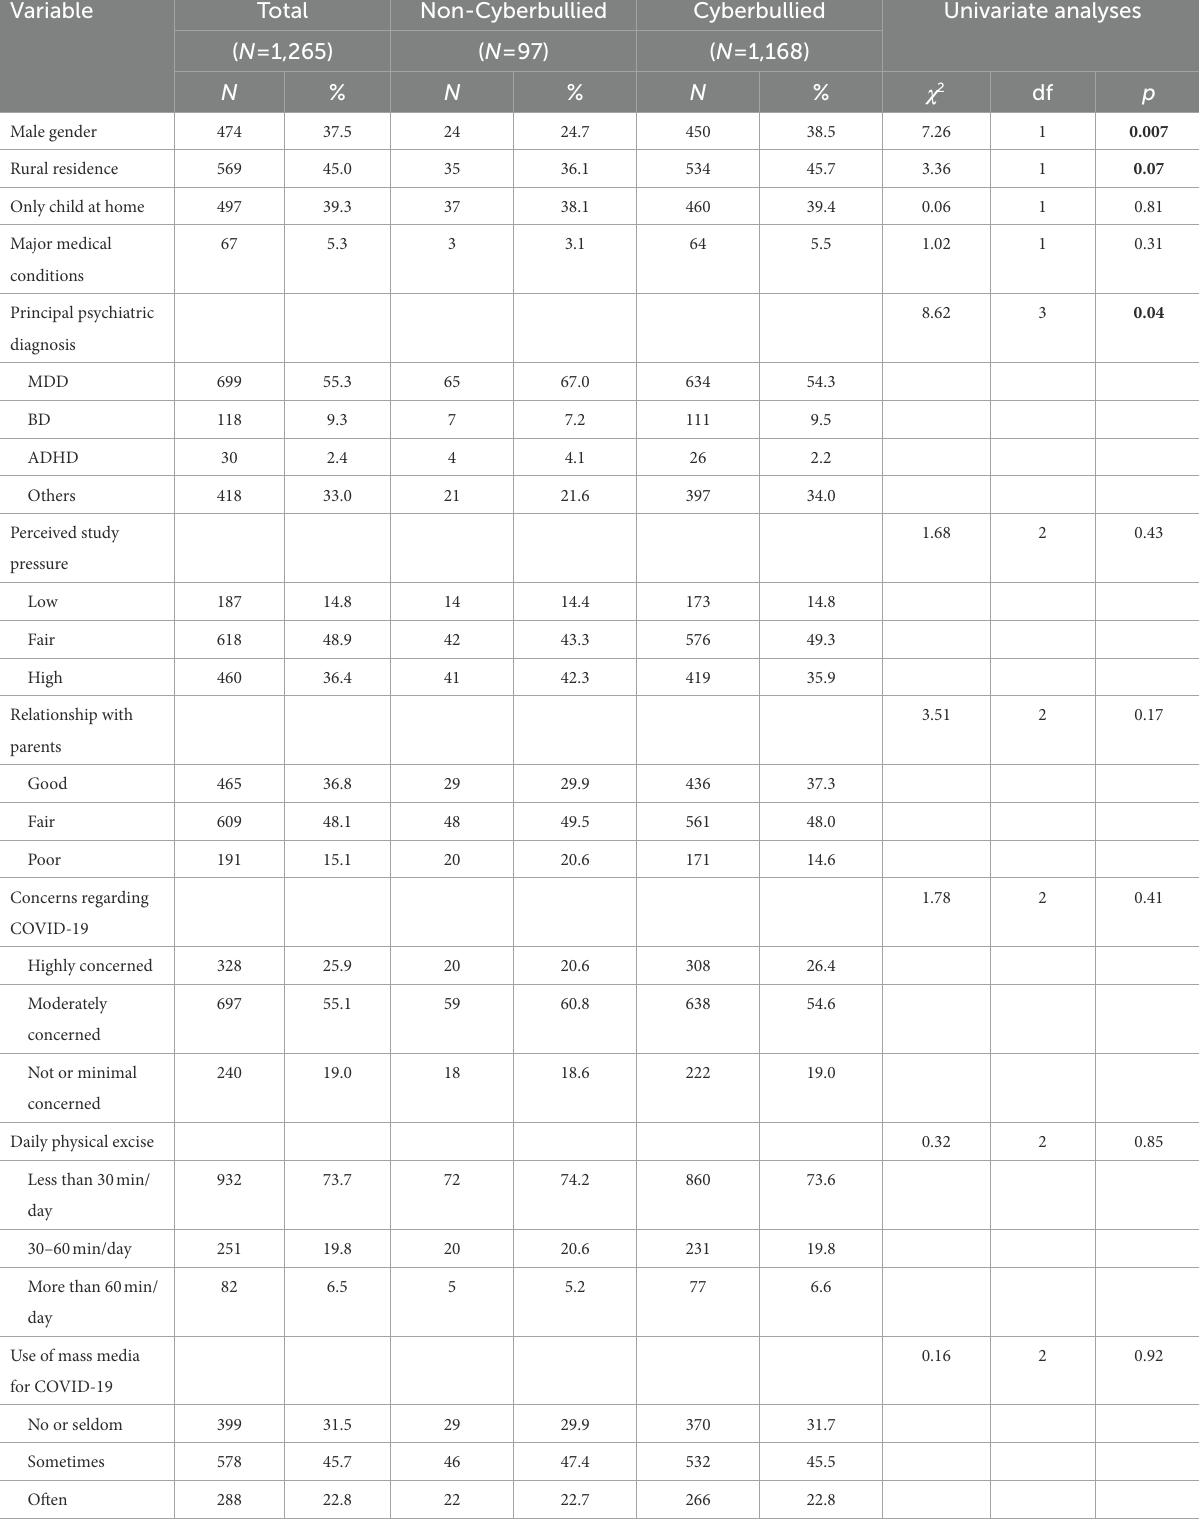
TABLE 1 Socio-demographic and clinical characteristics of clinically stable adolescent psychiatric patients. Variable Total Non-Cyberbullied Cyberbullied Univariate